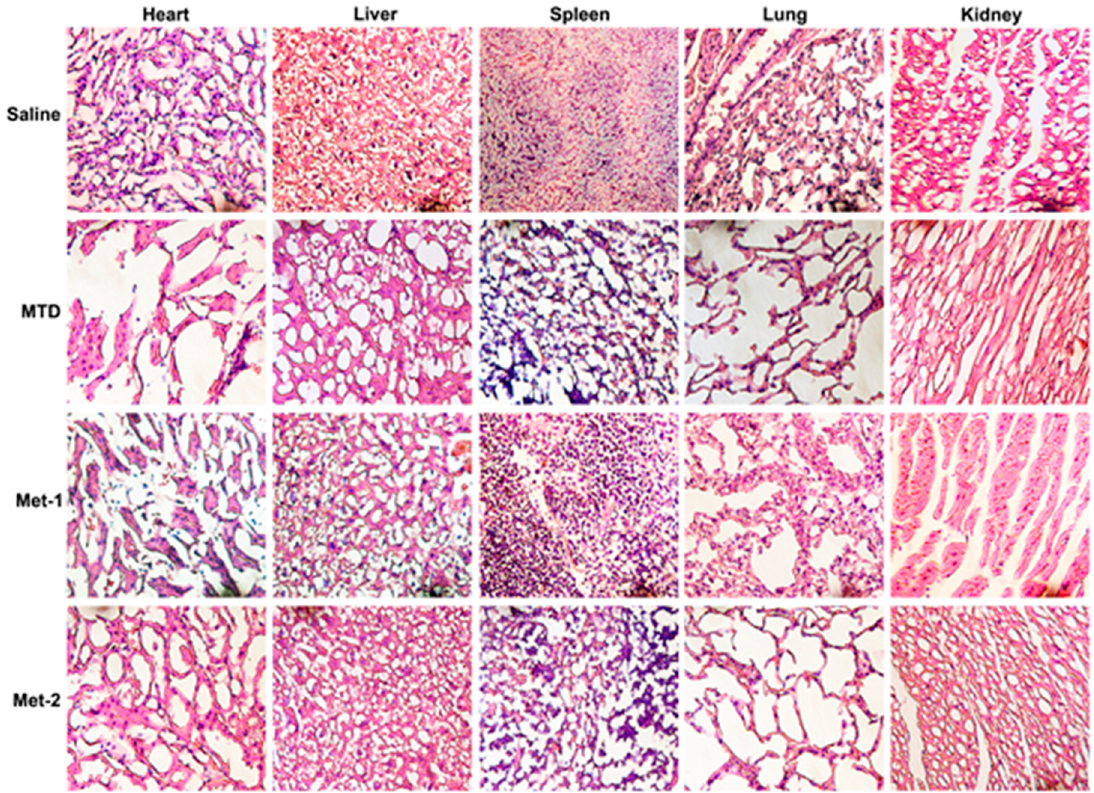
Figure 2. After 21 days of treatment, the major organs (heart, kidney, liver, lung and spleen) were harvested from mice and then stained with H&E. Cyclophosphamide at different schedules was given for three weeks. The mice were killed on day 22 and tissues were collected and H&E staining was performed. MTD: 3 doses of 150 mg/kg each, for the first week only; Met-1: 170 mg/kg every 6 days; Met-2: 25 mg/kg every other day. ×400.